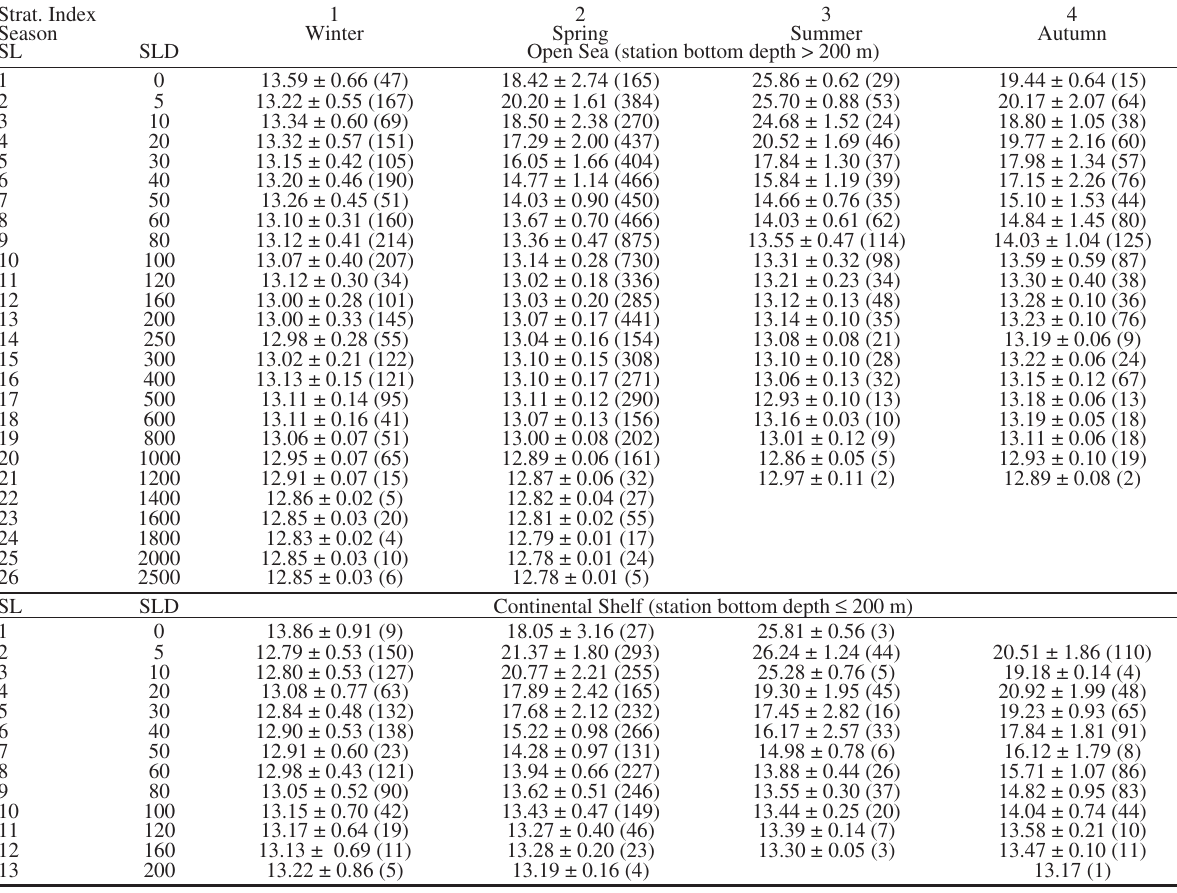
Table S10. – Potential temperature (°C) with depth and stratification of the water column in the Catalan Sea (NW Mediterranean Sea). Shown are average ± standard deviation (number of data between parentheses). SL, Standard Level; SLD, Standard Level Depth (m). Strat. Index